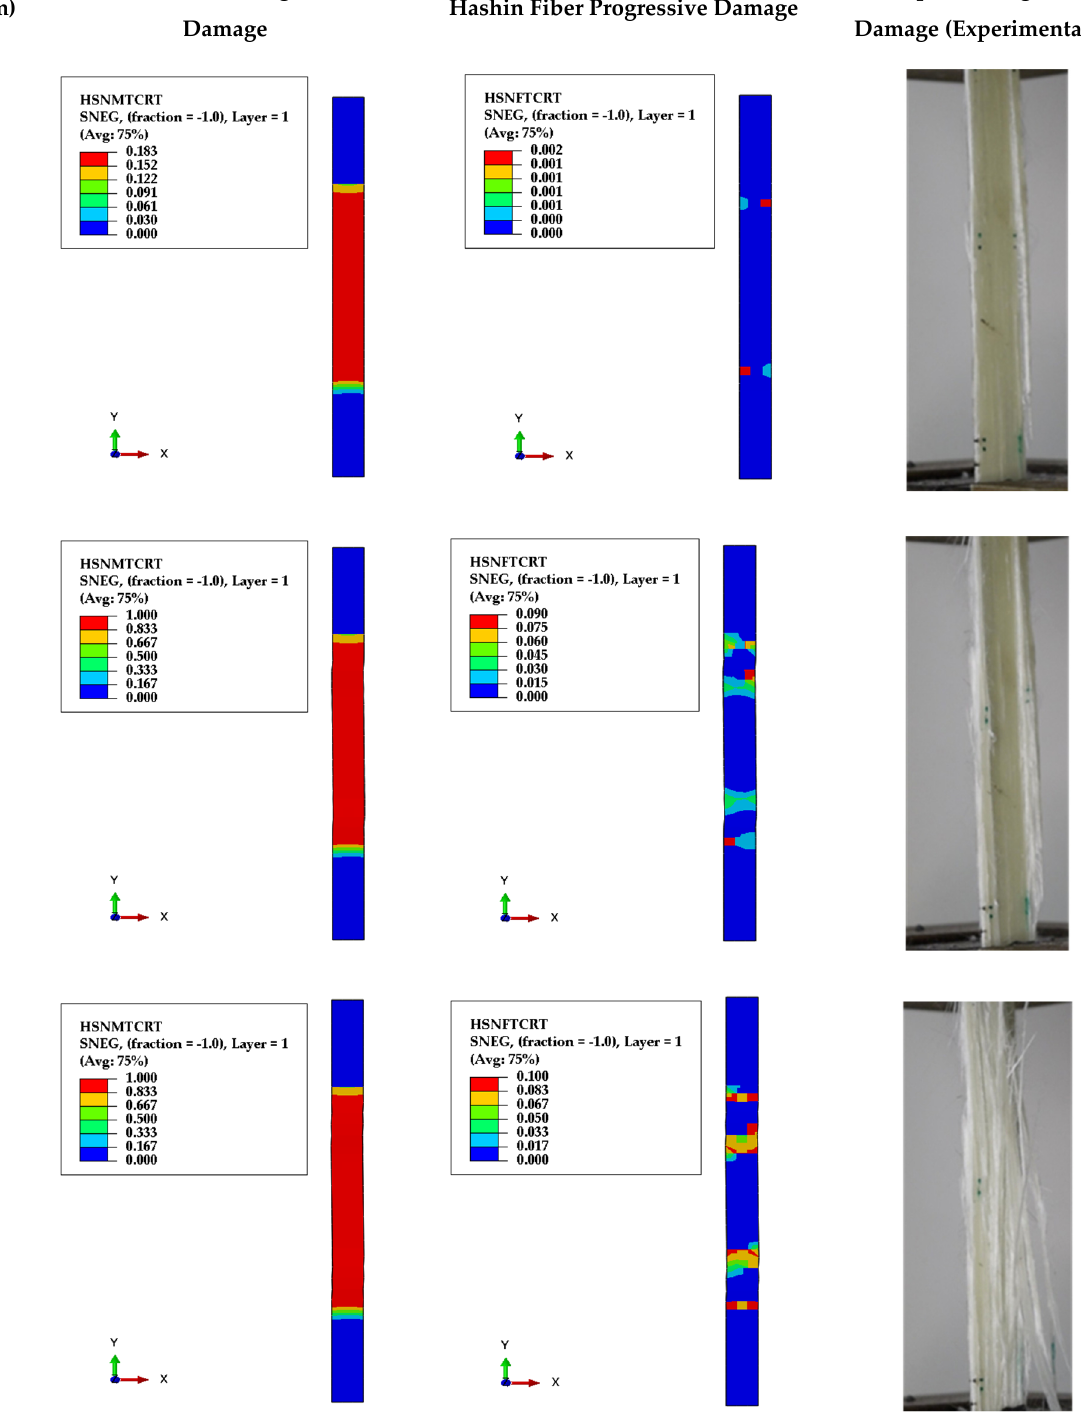
Figure 9. Numerical and experimental progressive damage failure of ASTM D3039 specimen.